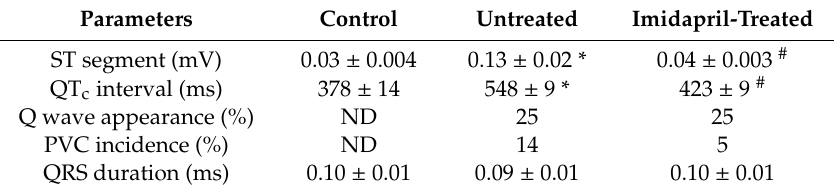
Table 5. Electrocardiographic parameters in rat hearts 21 days after coronary artery occlusion with or without ACE inhibitor, imidapril (1 mg / kg / day)